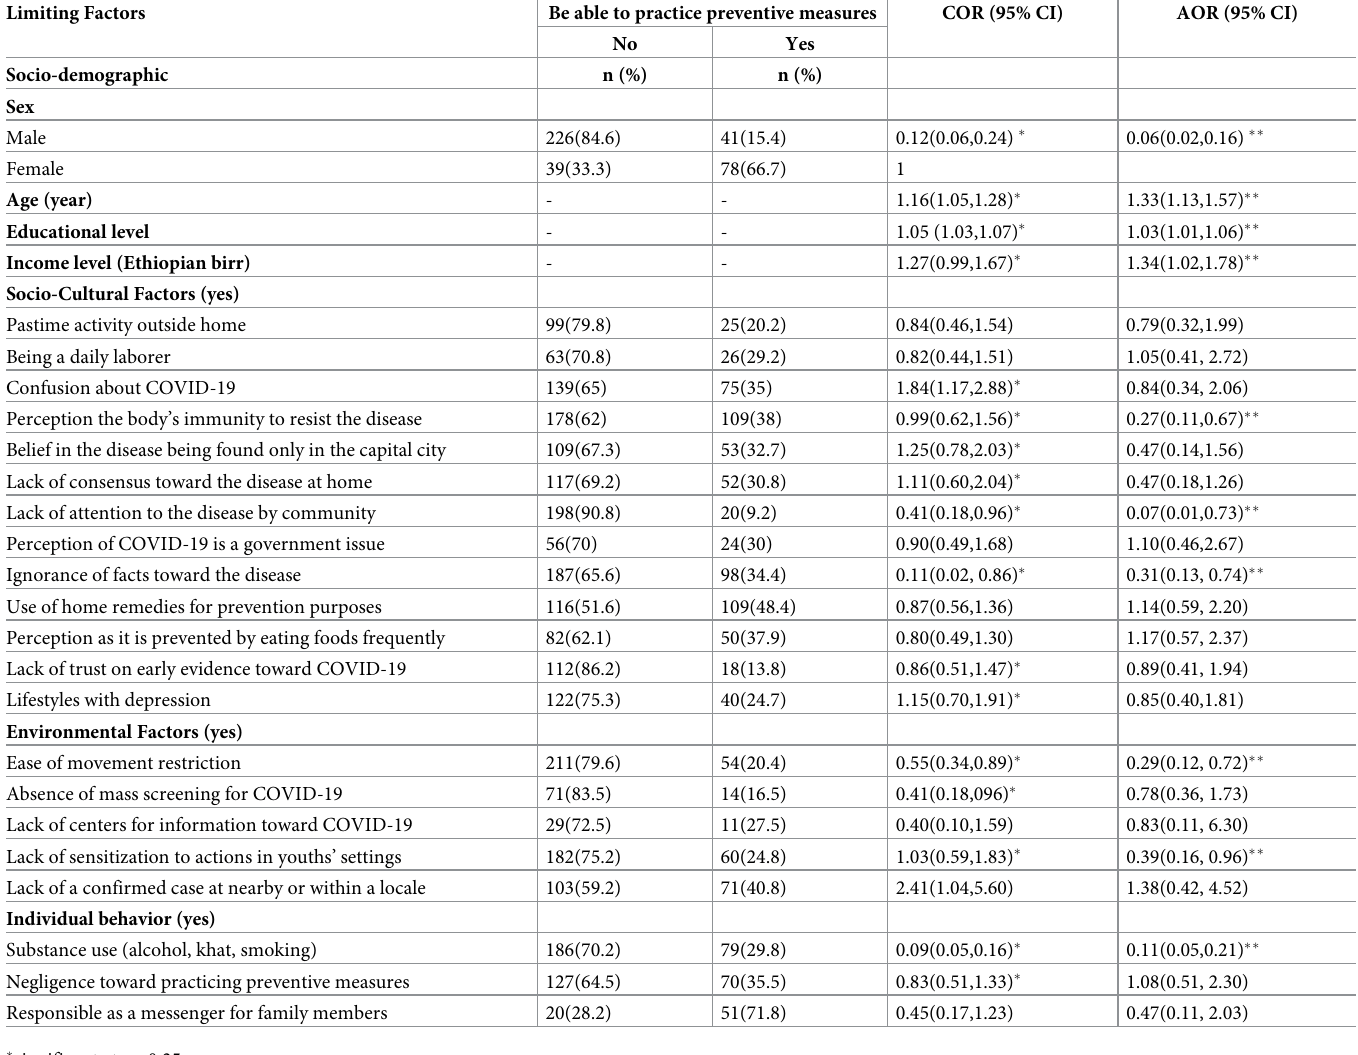
Table 4. Logistic regression predicting adherence to preventive measures by youths, OSZSF, 2020 (n =